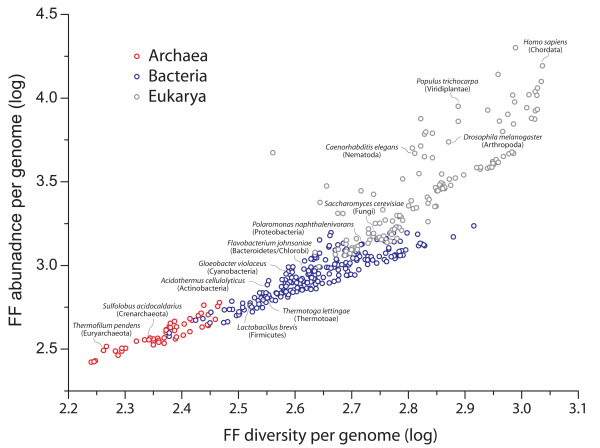
Plots of use and reuse of FFs in proteomes. The sum of multiple occurrences of FFs was plotted against the number of distinct FFs for each of 420 proteomes of free-living organisms, including 48 Archaea (red circles), 239 Bacteria (blue circles), and 133 Eukarya (gray circles). Both axes are in logarithmic scale.